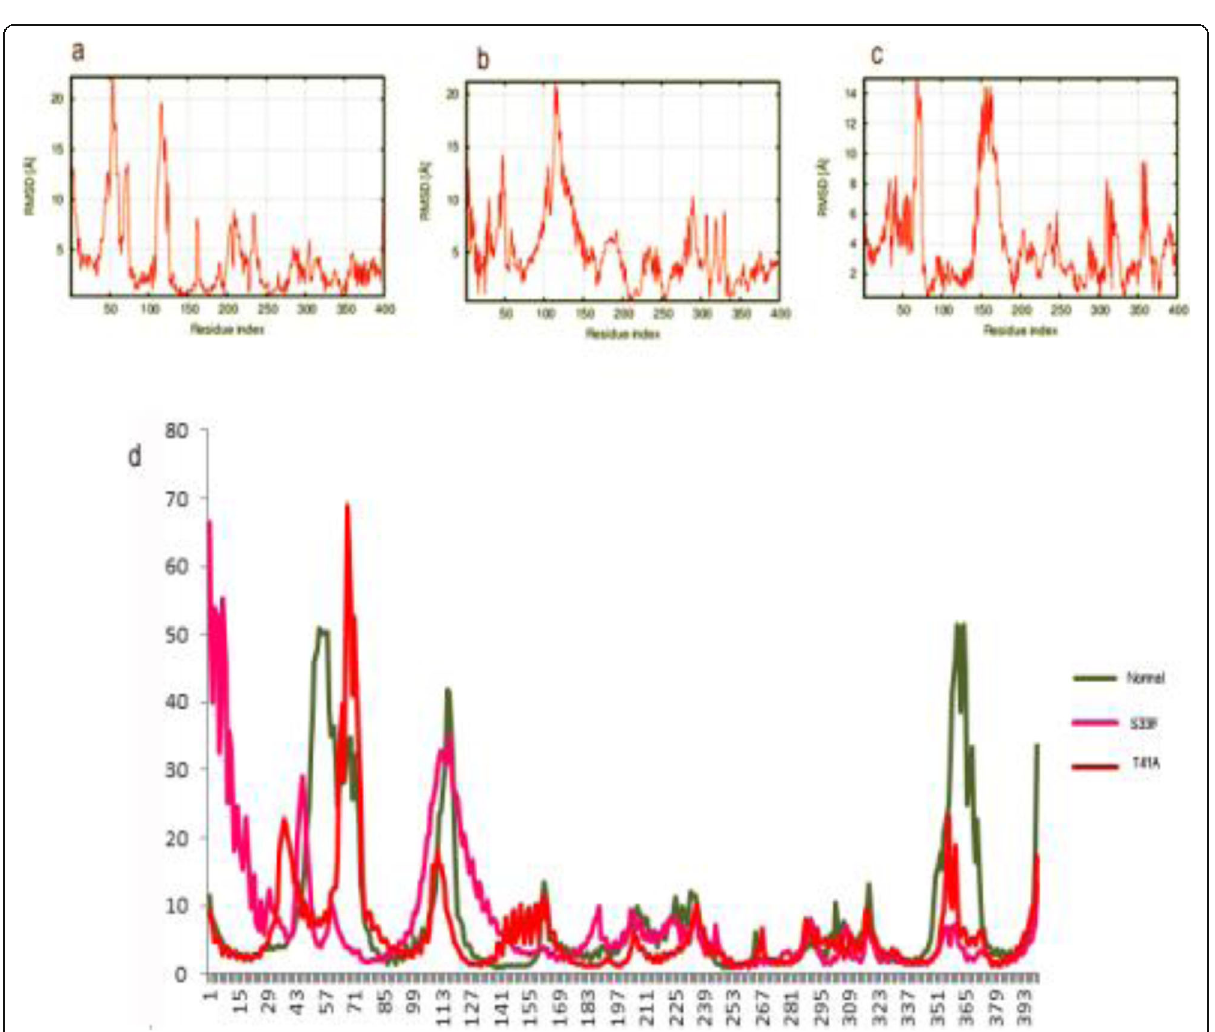
Fig. 8 Plots to investigate the stability and fluctuation of MD trajectories for a wild type and mutant CTNNB1 systems. RMSD Plots computed through each system trajectory ( a ) Wild type CTNNB1 ( b ) S33F mutant of CTNNB1 ( c ) T41A mutant of CTNNB1. d RMSF plot for mutant and